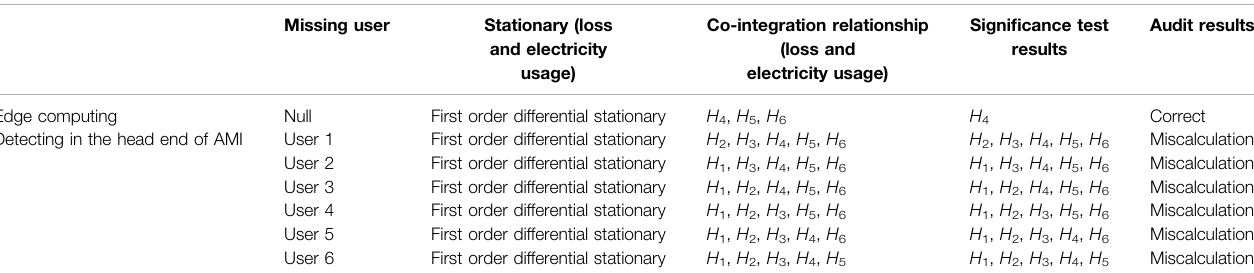
TABLE 5 | Result of Granger attribution test at the head end of